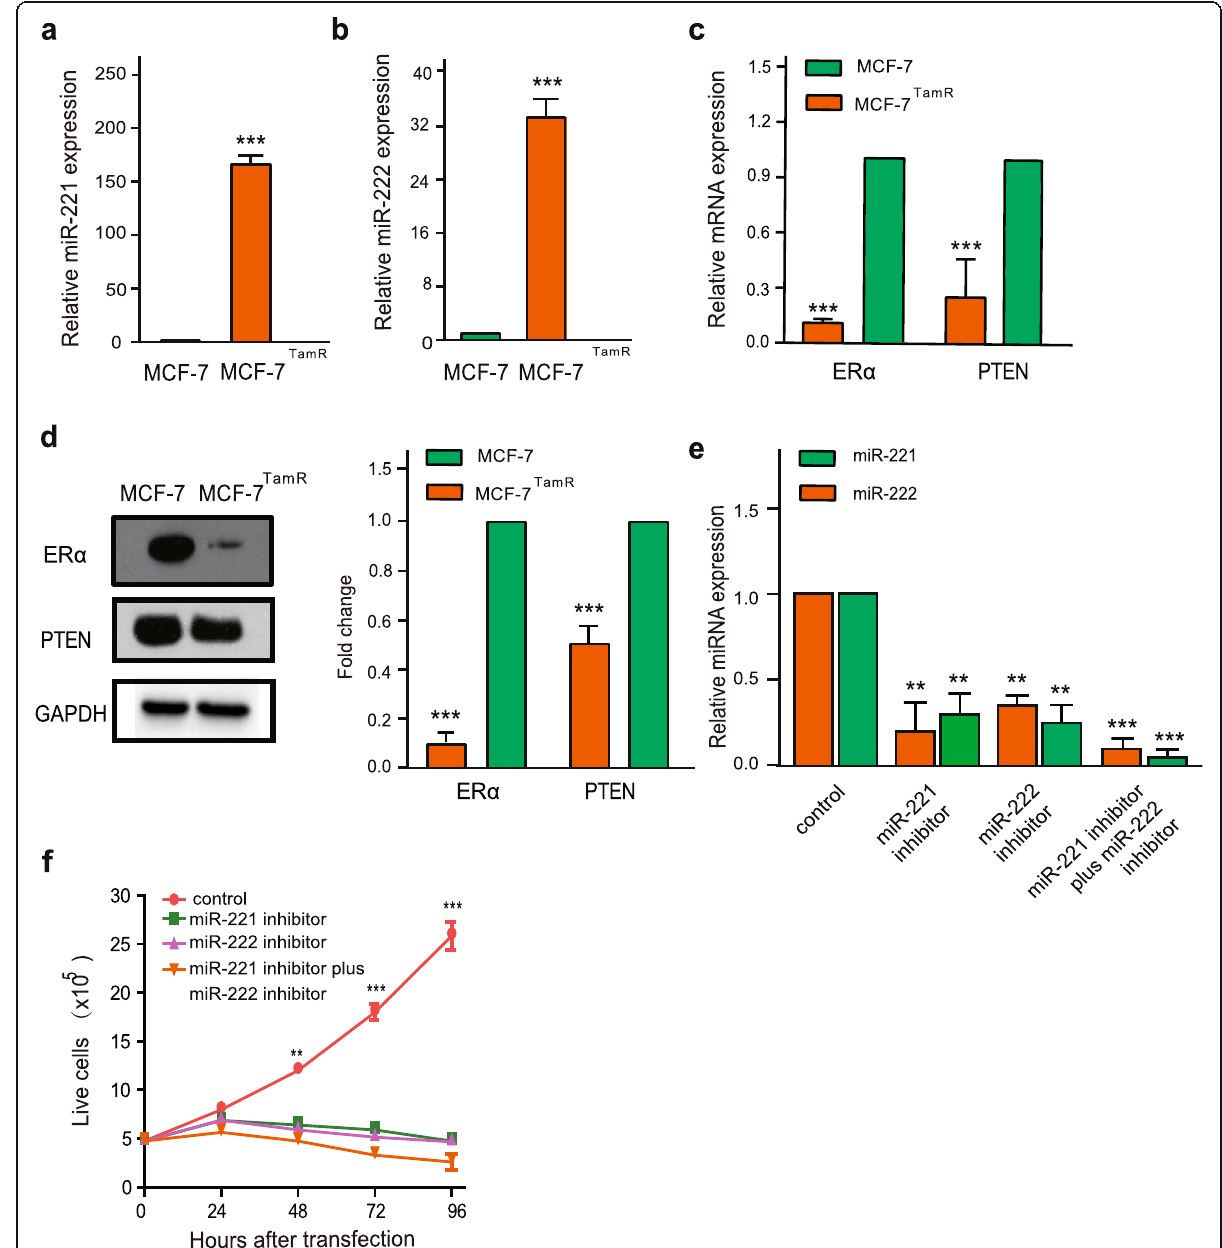
Fig. 2 Inhibition of the miR-221/222 network restored the sensitivity of MCF-7 TamR cells to tamoxifen. Expression of miR-221 ( a ), miR-222 ( b ), ER α and PTEN ( c ) in MCF-7 and MCF-7 TamR cells determined by qRT-PCR. d The protein level of ER α and PTEN in MCF-7 and MCF-7 TamR cells was analyzed by western blotting. e The expression of miR-221 and miR-222 of MCF-7 TamR cells was analyzed by qRT-PCR at 48 h after the transfection of miR-221 and miR-222 inhibitors, and f The growth of MCF-7 TamR cells in the presence of 15 μ M 4-hydroxytamoxifen was examined by the